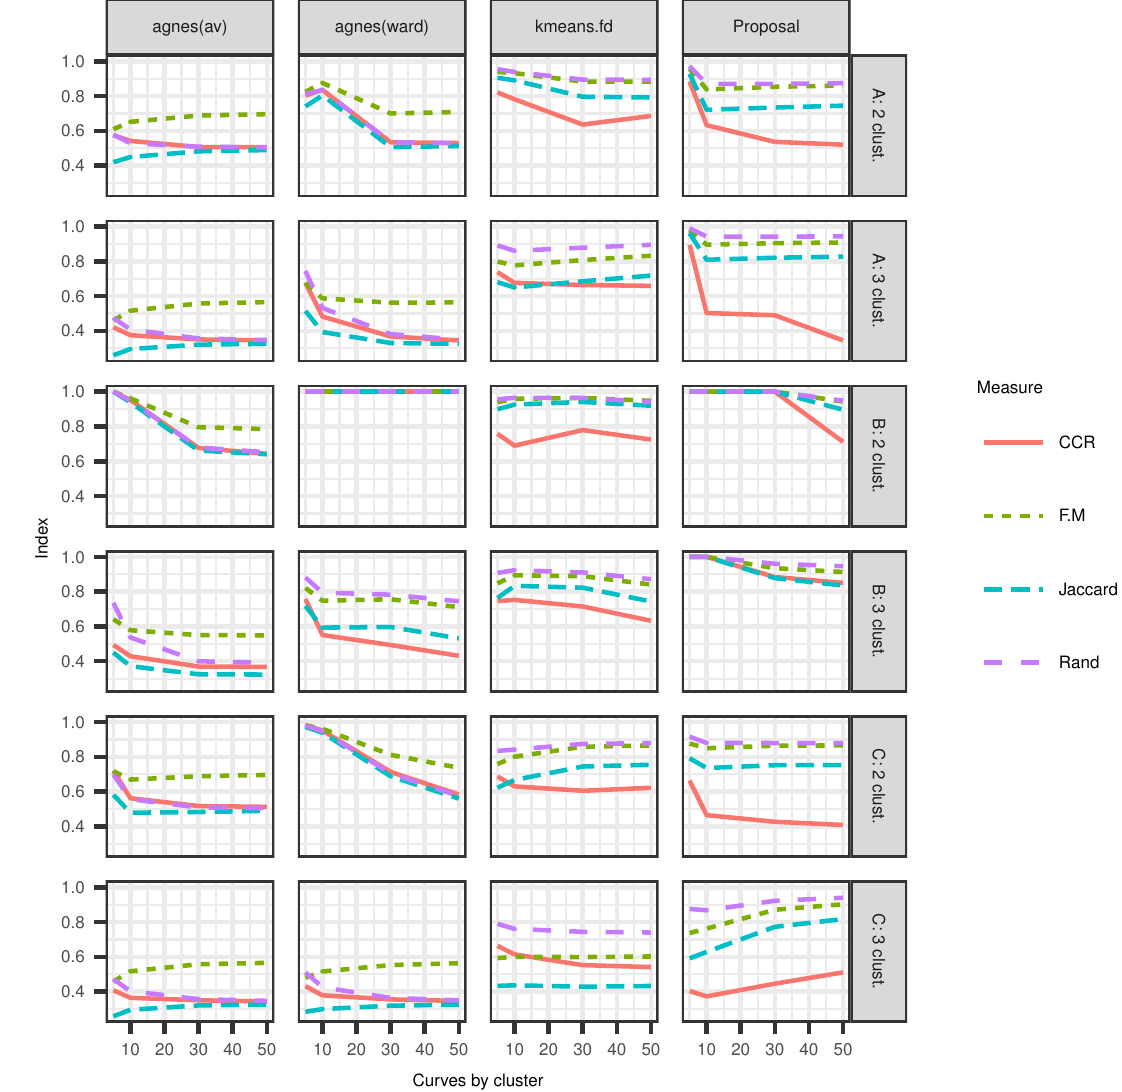
Figure 6. Performance indexes when two and three clusters of ( A ) Normal ( µ , σ 2 ) , ( B ) Gamma ( α , β ) , and ( C ) Beta ( α , β ) distributions with one atypical curve are